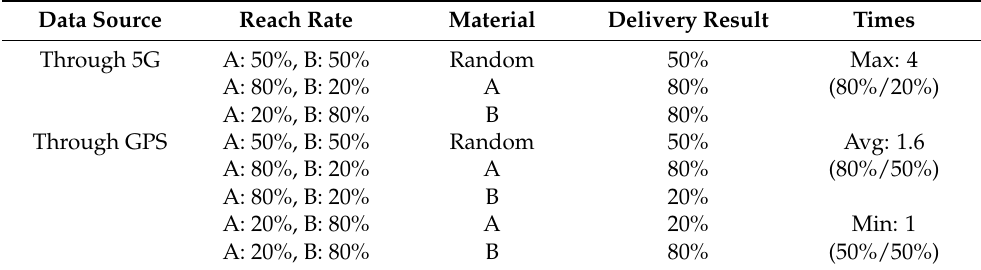
Table 20. Comparison of delivery effectiveness on upcoming passers nearby outdoor media.